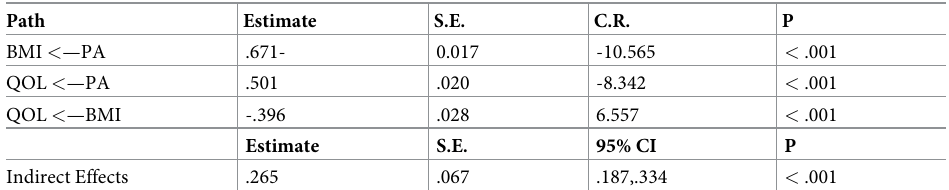
Table 4. Standardized path coefficients of the mediation